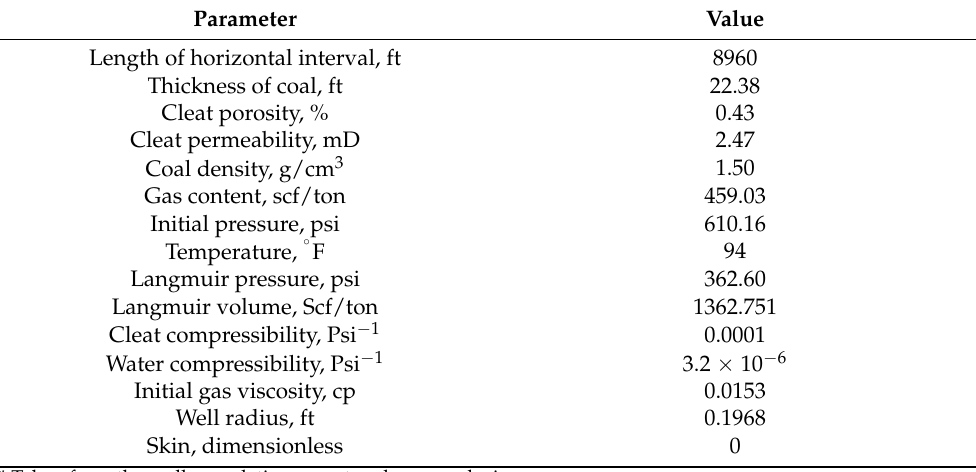
Table 5. Reservoir properties * for the target well in the Qinshui Basin,